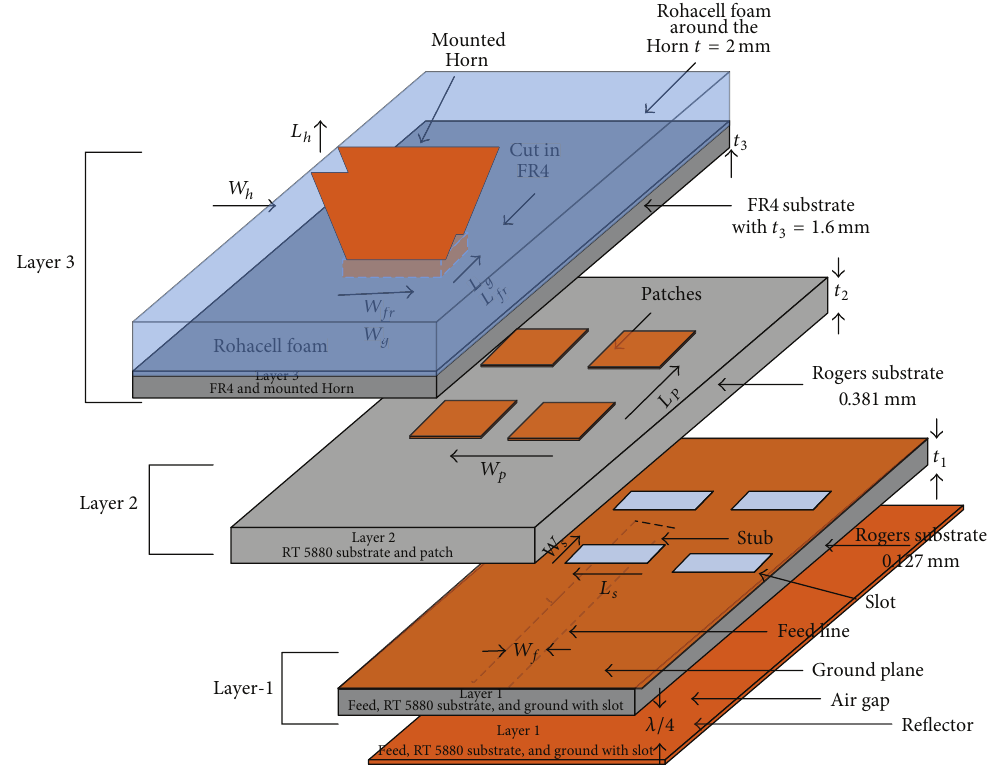
Figure 4: Exploded view of 2 × 2 multilayer array with 𝜆/4